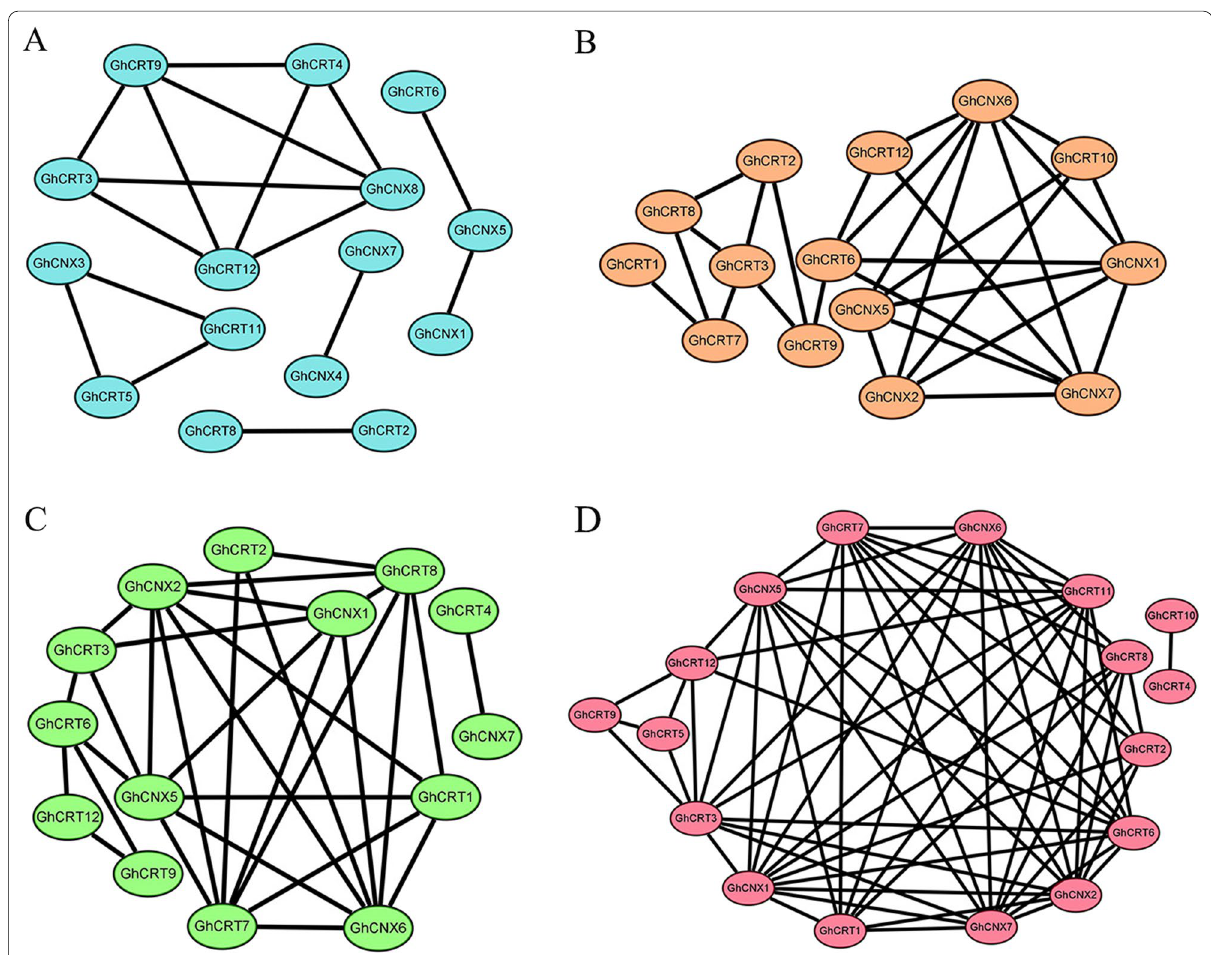
Fig. 10 Co-expression network of cotton GhCNXs genes under four abiotic stresses. A Co-expression network of genes under cold stress. B Co-expression network of genes under hot stress. C Co-expression network of genes under salt stress. D Co-expression network of genes under natural drought stress simulated by